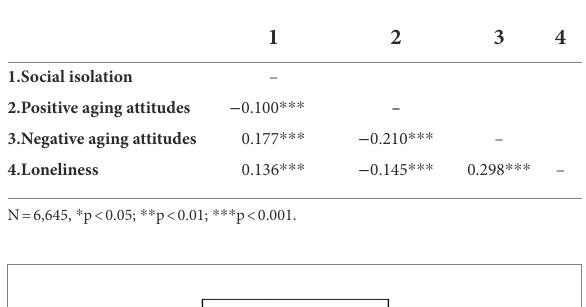
TABLE 2 Correlations of core variables.